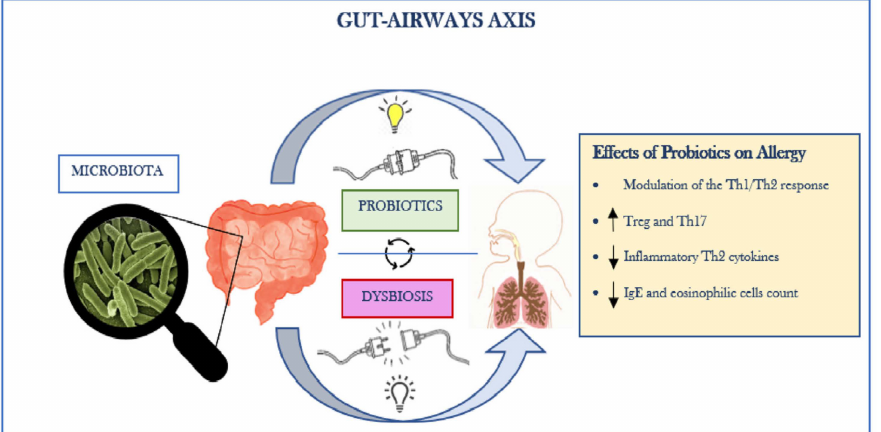
Figure 1. The Gut–Airways